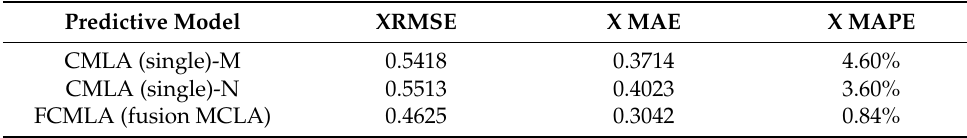
Table 4. Fault location performance of different models.